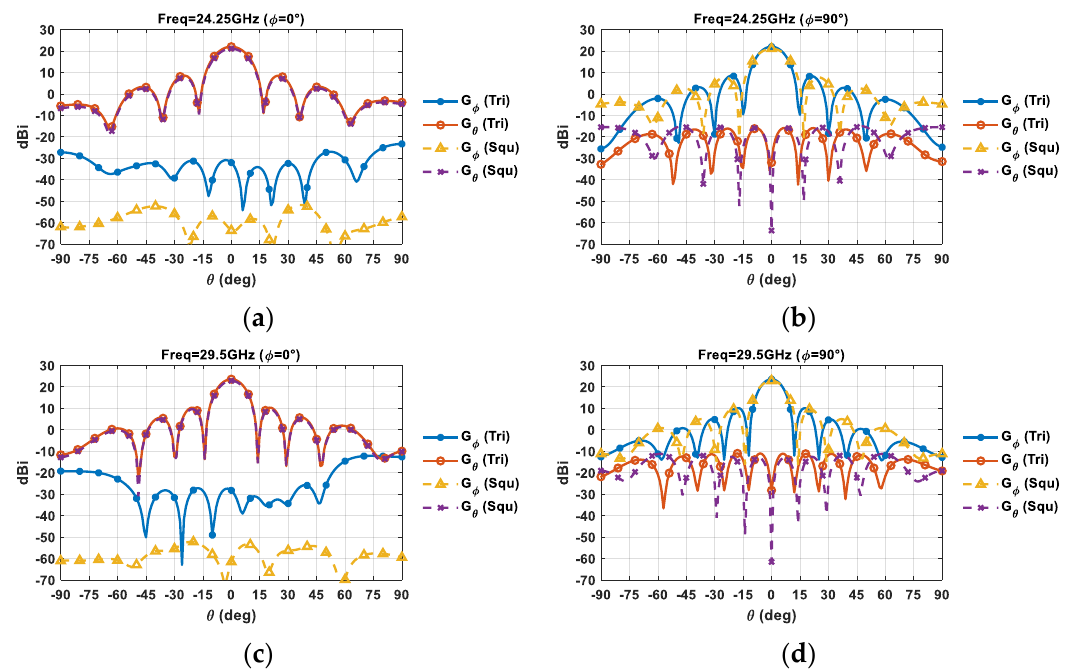
Figure 15. Simulated realized gain for a planar array composed of 64 elements at a broadside direction: ( a ) 24.25 GHz φ = 0 ◦ ; ( b ) 24.25 GHz φ = 90 ◦ ; ( c ) 29.5 GHz φ = 0 ◦ ; and ( d ) 29.5 GHz φ = 90 ◦